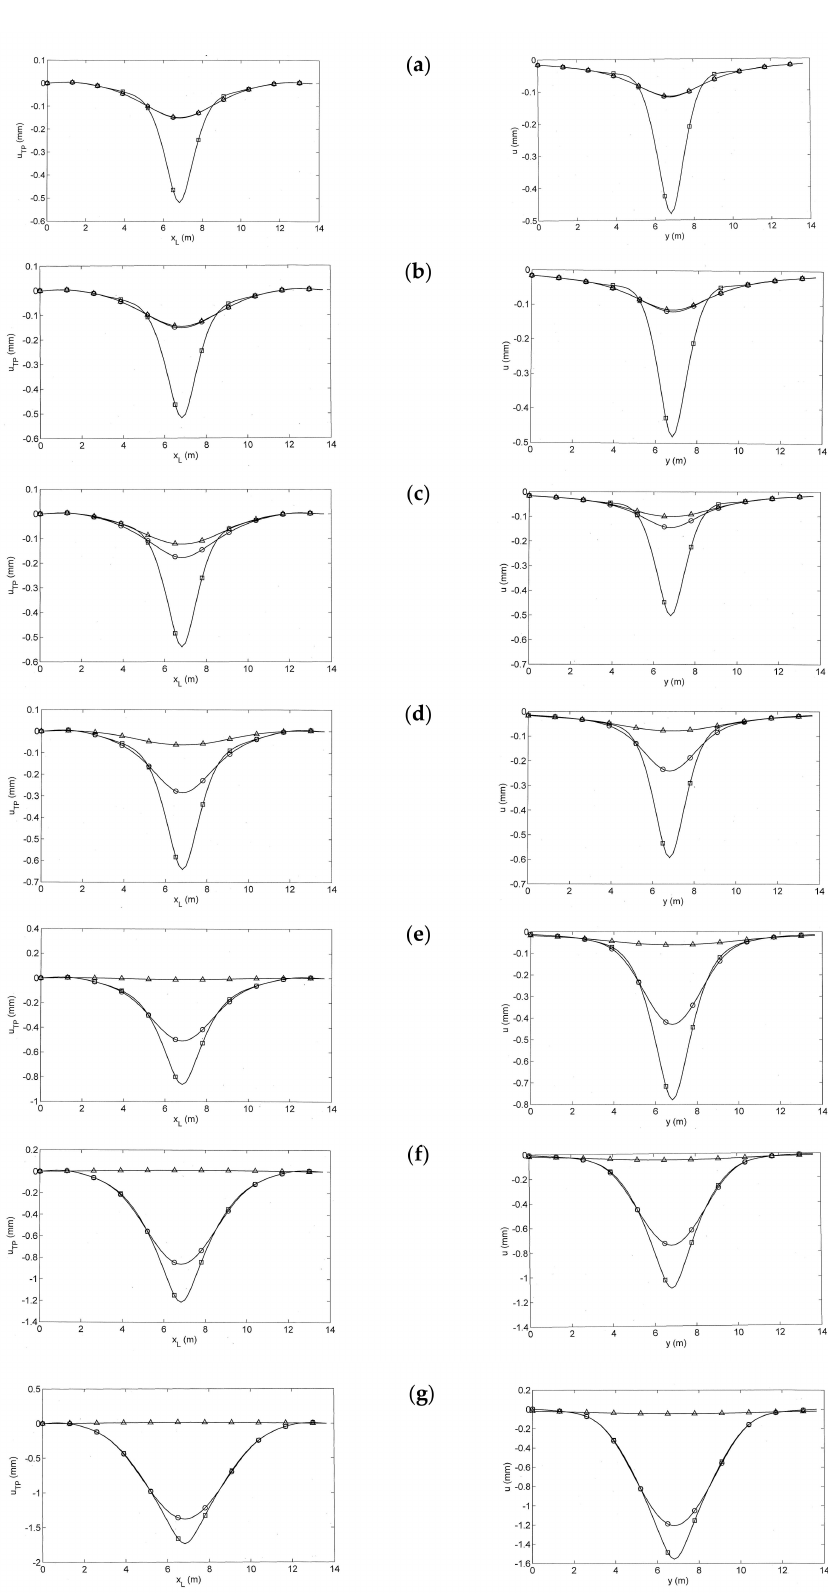
Figure 9. Calculated distributions of the slab track displacements for different lengths of track plate damage (gap to base layer): L D = ( a ) 0 (intact), ( b ) 0.65, ( c ) 1.95, ( d ) 3.25, ( e ) 4.55, ( f ) 5.85, and ( g ) 7.15 m; rail, track plate, (cid:52) base layer, FEM results (left), FEBEM results (cid:50) (cid:35)